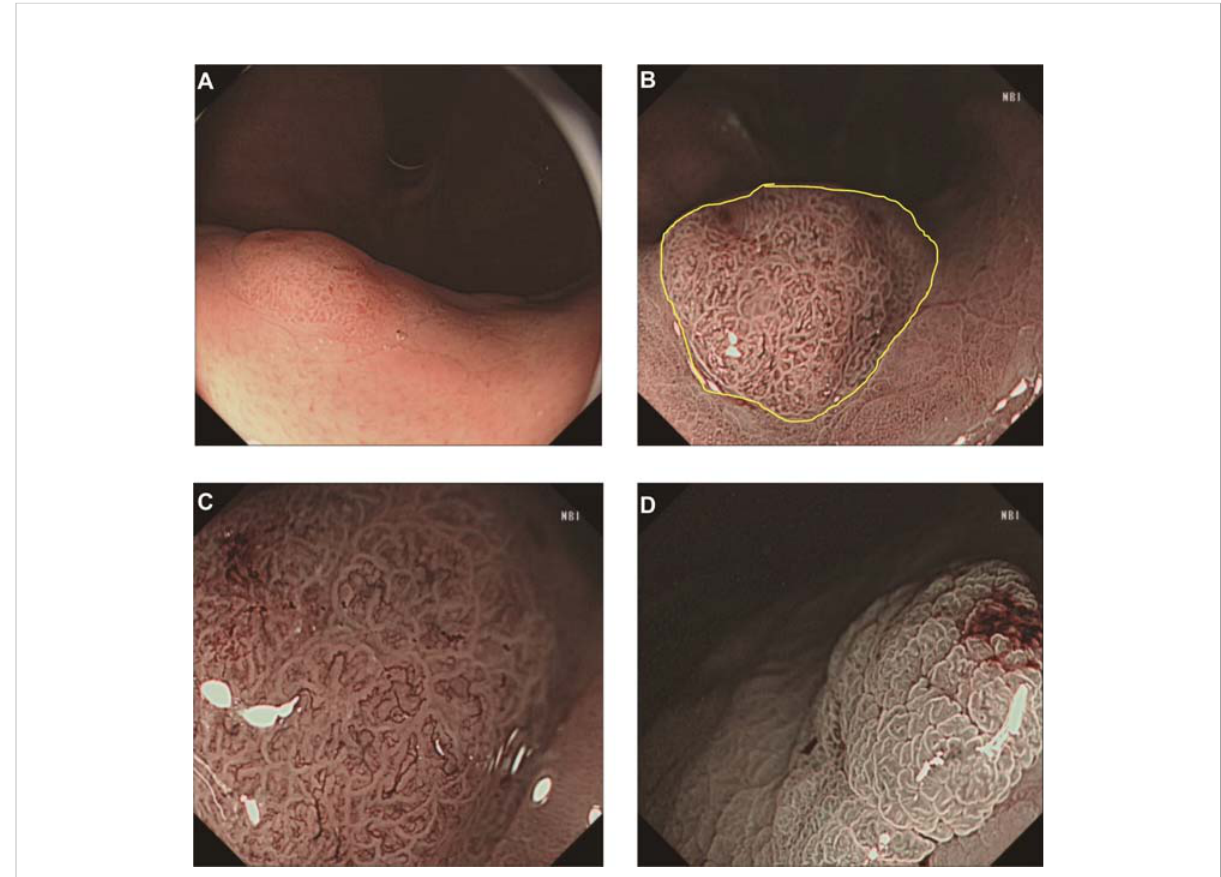
FIGURE 1 Endoscopic images. Esophagogastroduodenoscopy showed a yellowish and elevated lesion in the upper part of the greater curvature of the H. pylori -negative background (A) . NBI showed a de fi ned light brownish elevated area (B) . Magnifying narrow-band imaging revealed an expanded and thinned white zone with changed polarity, as well as dilated and irregular microvascular architecture. The granular microsurface structure of this lesion was stained with acetic acid (D) . The yellow dotted line indicates the extent of the lesion diagnosed as cancer by